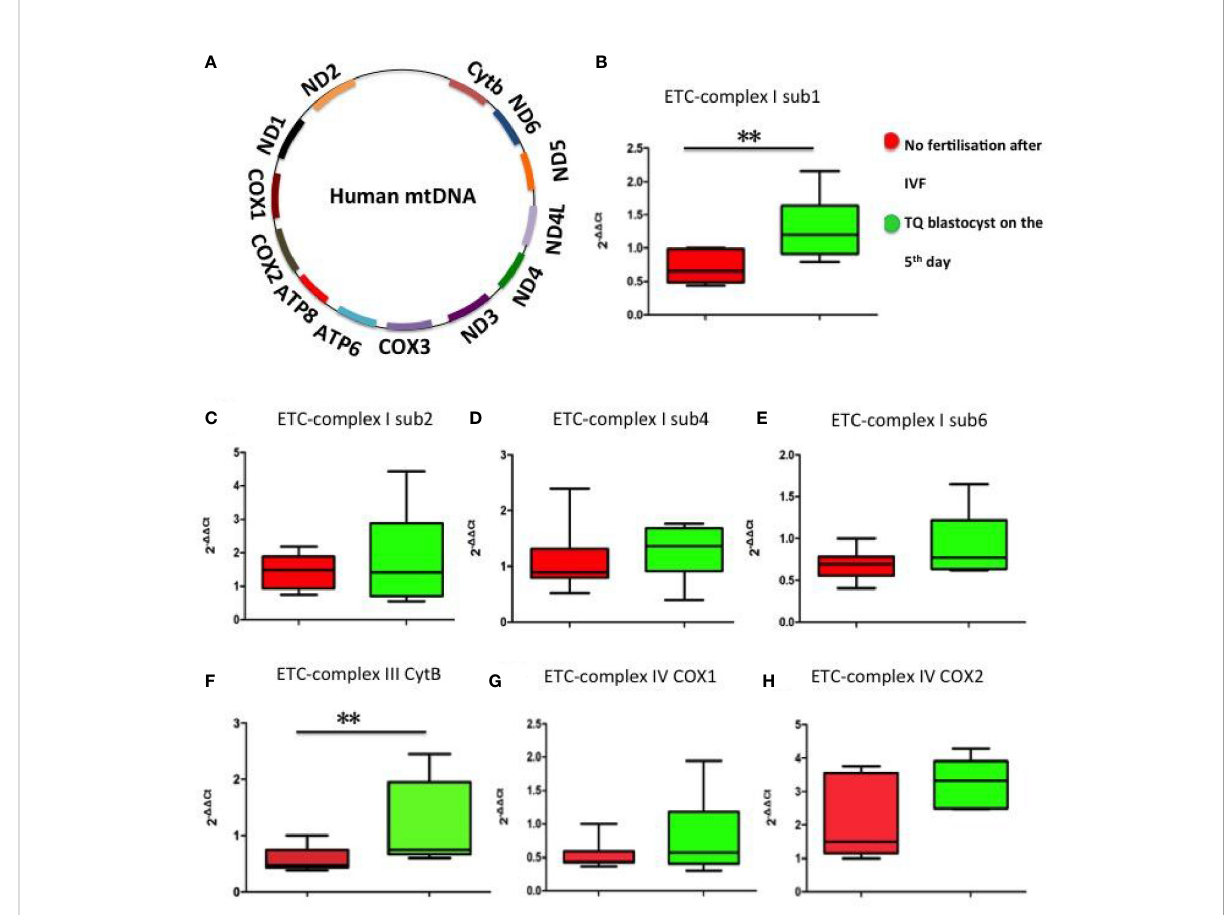
FIGURE 5 Representation of the mitochondrial ETC genes and mRNA expression levels of mitochondrial ETC genes in FF exosomes. (A) Representation of the 13 mitochondrial ETC genes. (B) ETC complex I sub1; (C) ETC complex I sub2; (D) ETC complex I sub4; (E) ETC complex I sub6; (F) ETC complex III CytB; (G) ETC complex IV COX1; (H) ETC complex IV COX2. Comparison between groups was performed using t-test. Data are presented as mean ± SD; **p<